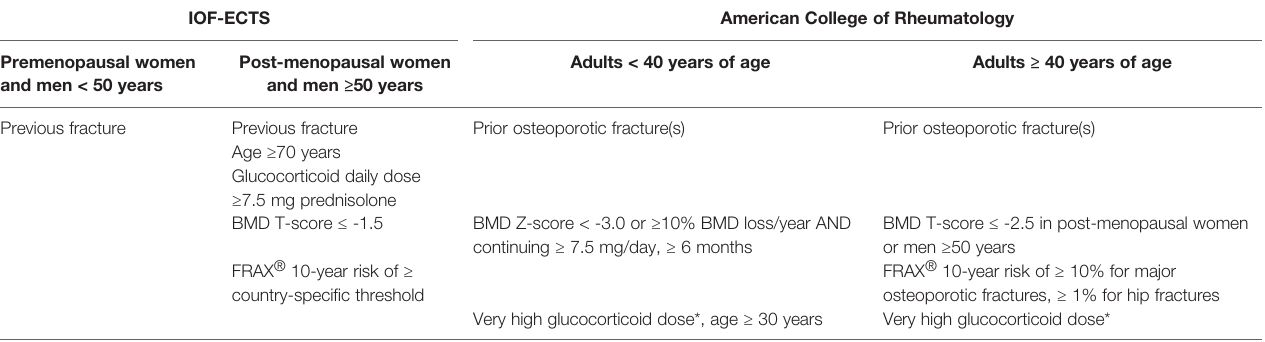
TABLE 5 | Fracture risk groups eligible for bone-sparing drugs in IOF-ECTS (96) and ACR guidelines (91) on GIOP.